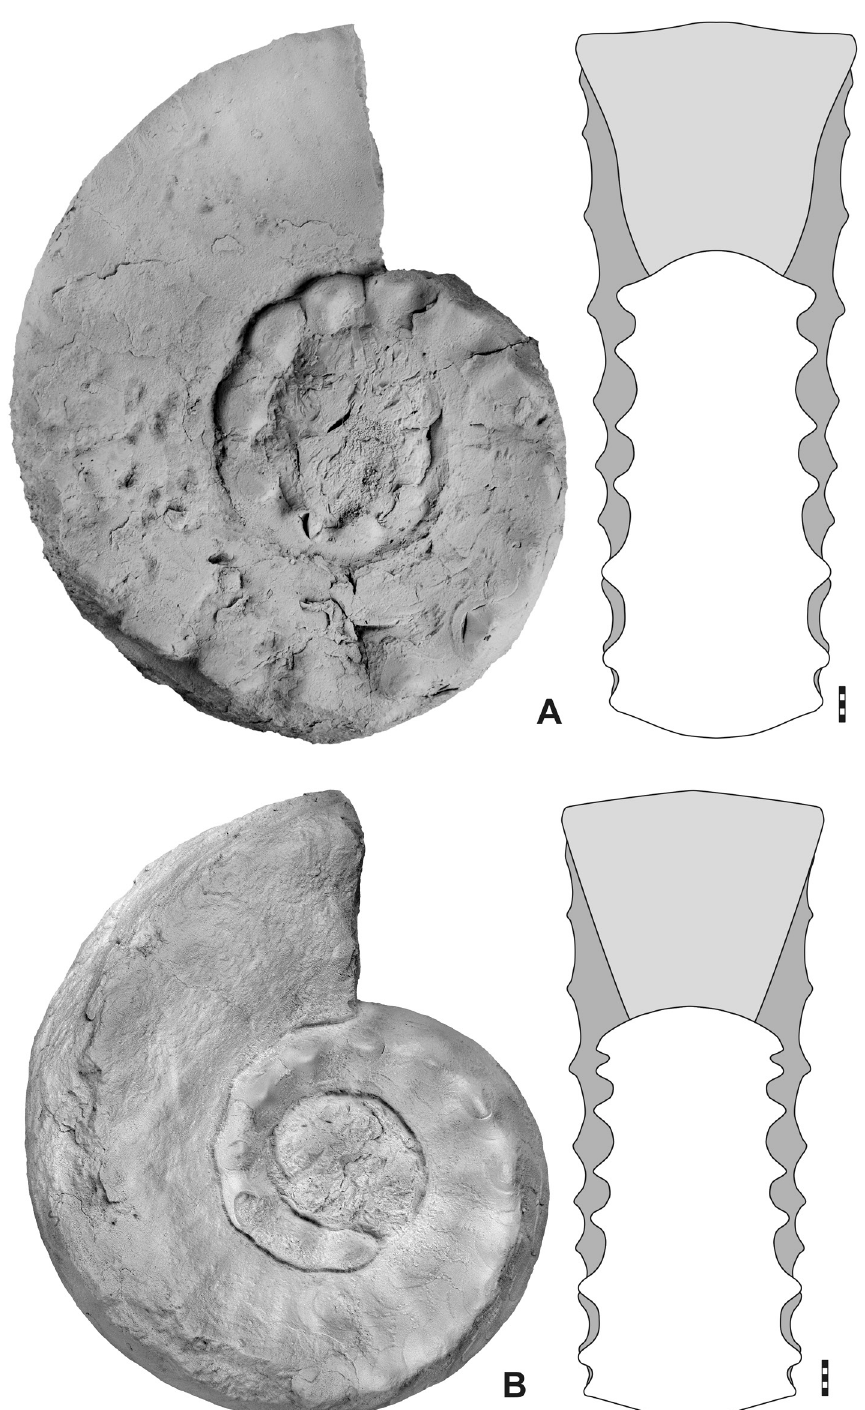
Fig. 28. Paratirolites vediensis Shevyrev, 1965, lateral and dorsal views. A . Specimen MB.C.29804, section G, -2.75 m. B . Specimen MB.C.29798, section E, float. Scale bar units = 1